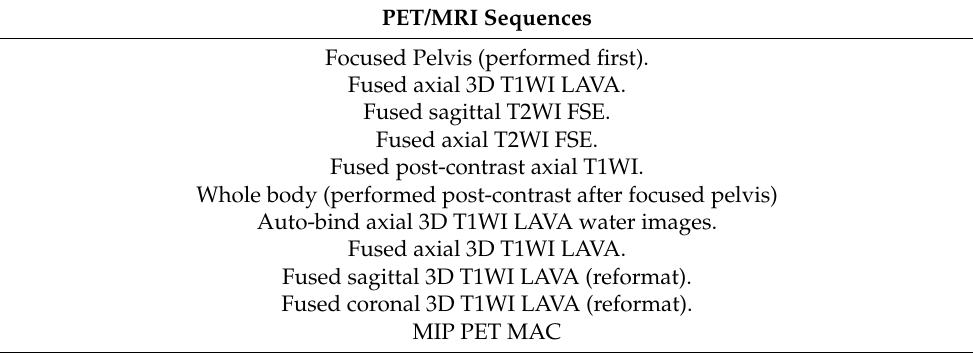
Table 2. PET/MRI pelvis protocol